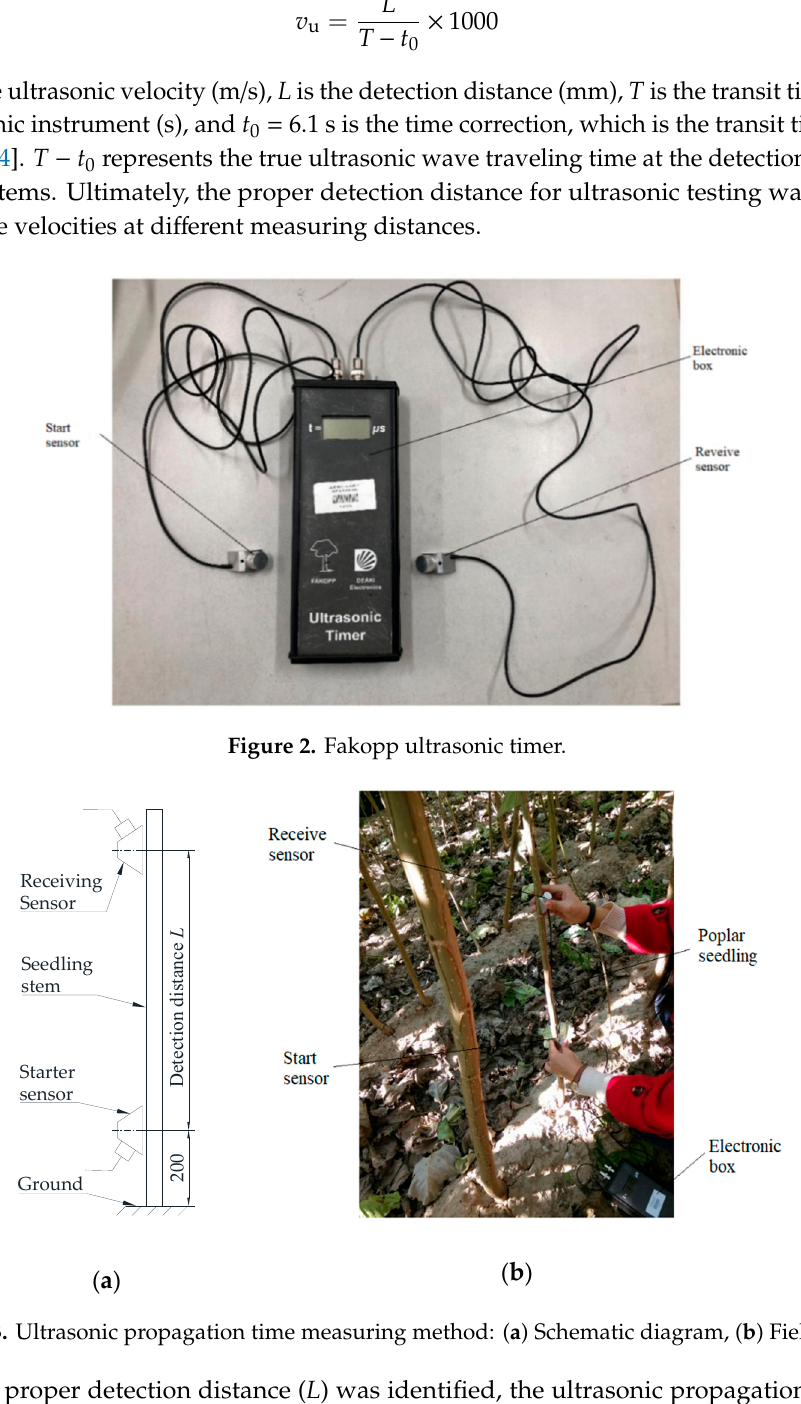
( c ) Figure 1. Schematic diagram of specimen preparation for MFA measurement: ( a ) disc sample